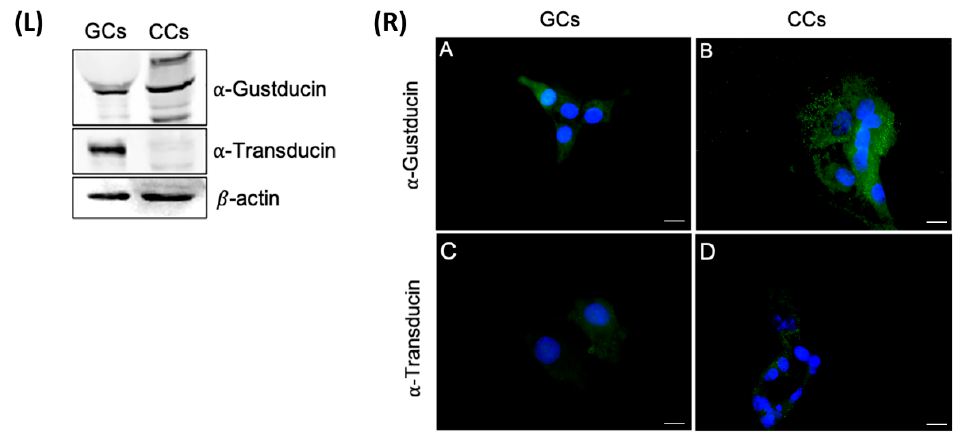
Figure 7. Left panel ( L ) The upper panel shows the detection of α -gustducin by Western blot with an anti- α -gustducin antibody, in CCs and GCs protein extracts. The central panel shows the detection of α -transducin by Western blot with an anti- α -transducin antibody in GCs and CCs protein extracts. β -actin was used as loading control. Right panel ( R ) Immunofluorescence localization of ( A , B ) α -gustducin, ( C , D ) α -transducin, in ( A , C ) granulosa and ( B , D ) cumulus cells. α -gustducin and α -transducin are stained in green. Nuclei were counterstained with DAPI (blue). Negative controls are shown in Figure S1. Scale bar = 15 μ m.